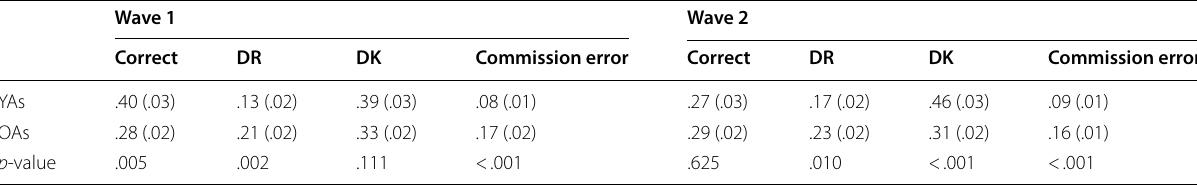
Table 2 Proportion of responses during the short-answer task in YAs and OAs in Waves 1 and 2 (standard error of the mean in